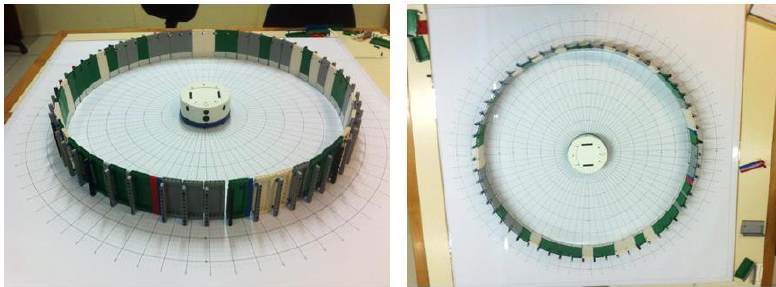
Figure 2. Setup for the traditional calibration